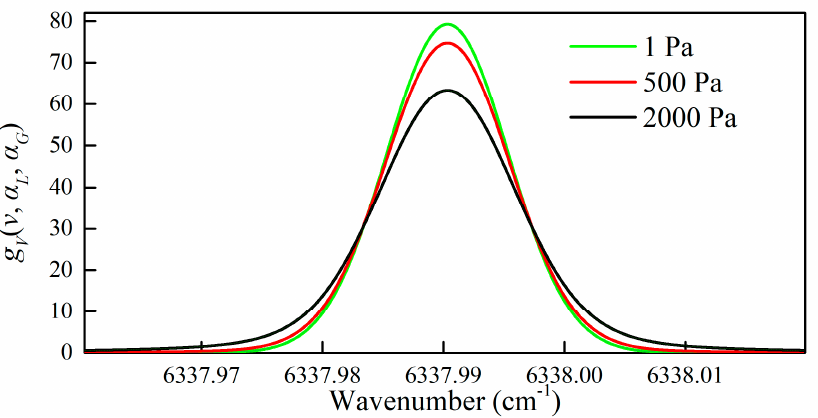
Figure 3. The simulated Voigt profile of Pe(12) line of CO 2 at different pressures (CO 2 concentration is 1000 ppm, temperature is 300 K).